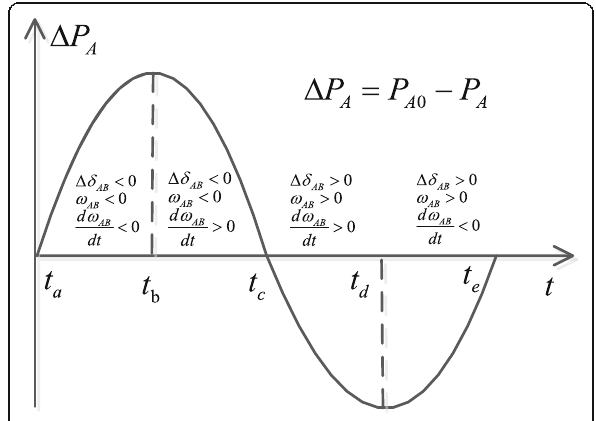
less than zero. As a result, ω will decrease from zero to a AB minimum value ω and δ will also decrease. The AB min AB transmission power of the tie line will decrease to the mini- mum value, and the power change of the transmission power Δ P will increase from zero to the maximum value A to t . as shown in Fig. 5 during the time from t a b Phase II is the backward deceleration phase. As shown in Fig. 5 during the time from t to t , d ω / dt > 0 and b c AB ω will increase from the minimum value to zero. The AB difference of the angular speed satisfies ω < ω < 0. AB min AB